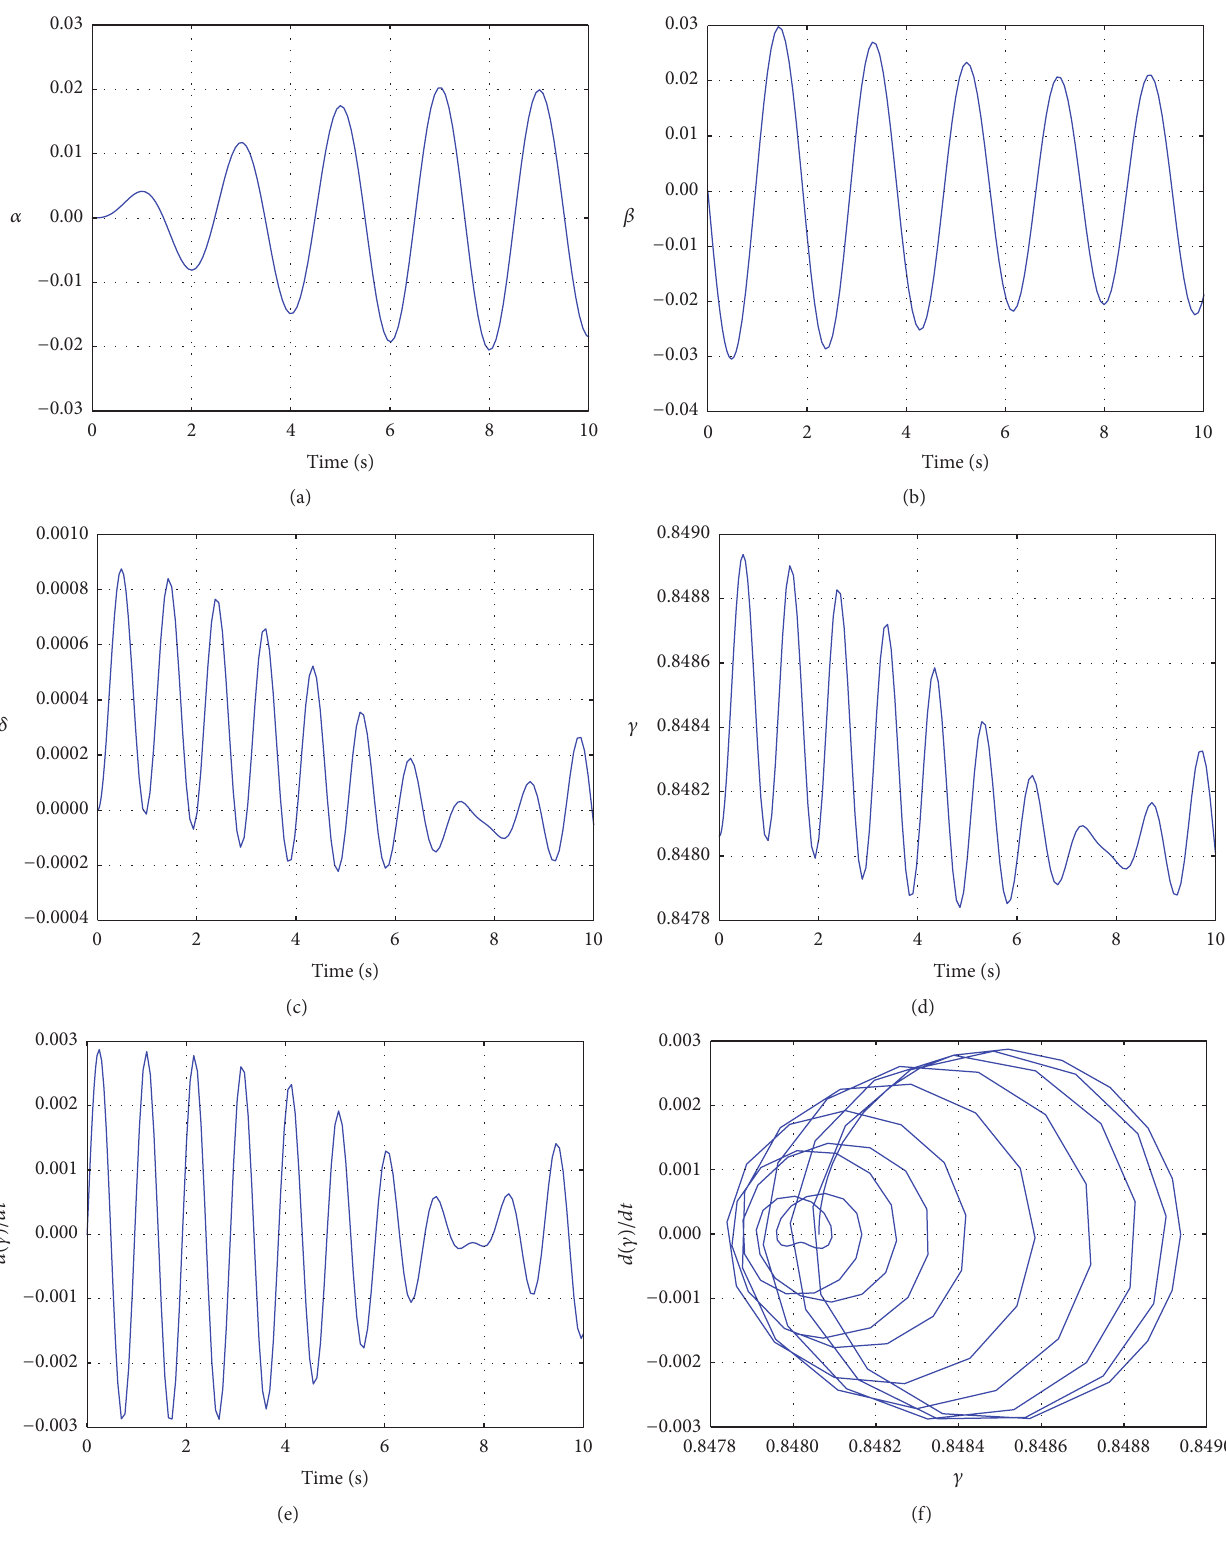
Figure 5: JModelica.org-derived numerical plots for angular coordinates 𝛼 = 𝛼(𝑡) (a); 𝛽 = 𝛽(𝑡) (b); 𝛿 = 𝛿(𝑡) (c); 𝛾 = 𝛾(𝑡) (d); 𝜔 𝛾 = 𝜔 𝛾 (𝑡) = ( 𝑑(𝛾(𝑡))/𝑑𝑡 ) (e); and 𝜔 𝛾 = 𝜔 𝛾 (𝛾) ; that is, (𝑑(𝛾(𝑡))/𝑑𝑡) = 𝑓(𝛾) (f), computed for system (13) with nonzero initial velocities 𝑉 𝐵 (0) = 0.5 (m/s) and 𝜔 𝛽 (0) ≈ −0.083